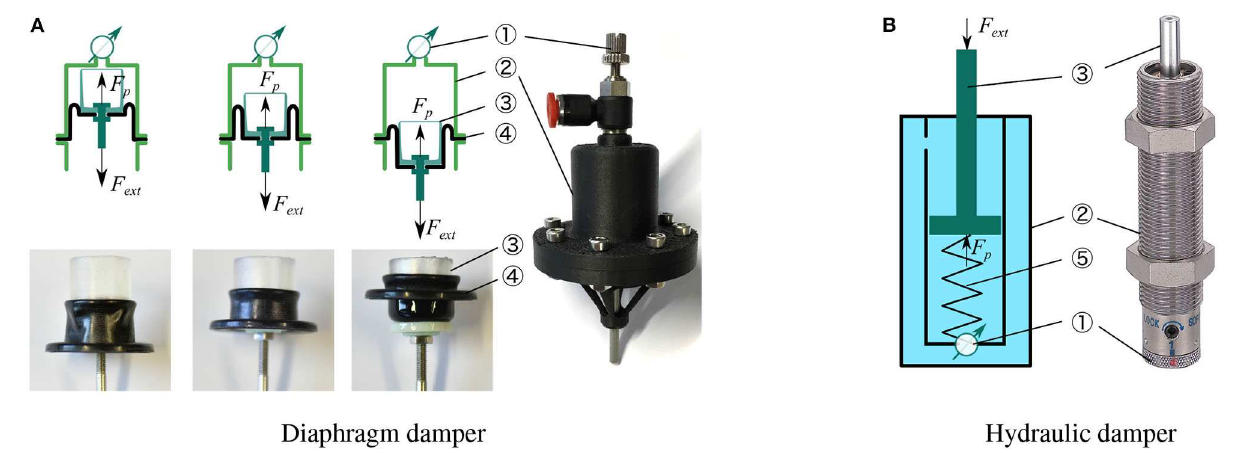
(cid:13) (cid:13) , a cylinder 2 , a (cid:13) (cid:13) with an recovery spring 5 to reset the